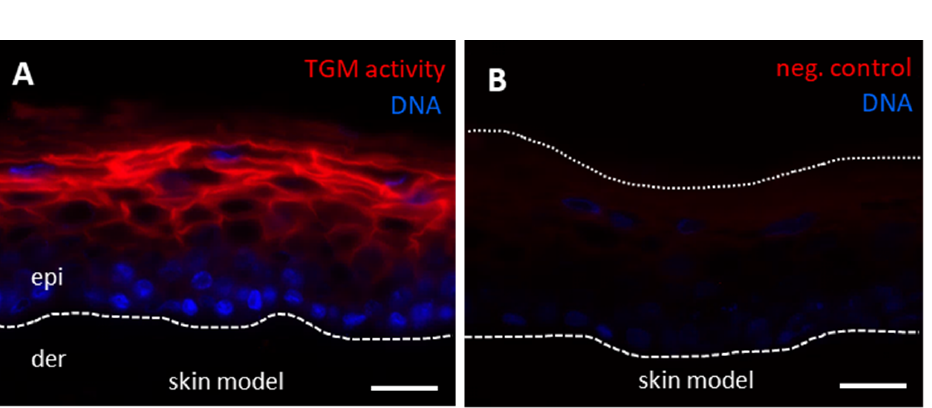
Figure 4. In situ labeling of transglutaminase (TGM) activity in chicken skin models and chicken skin. Skin models consisting of keratinocytes and fibroblasts isolated from chicks and cultured in vitro ( A , B ) and back skin ( C , D ), reticulate scales ( E , F ) and scutate scales ( G , H ) from chicken em- bryos (Hamburger and Hamilton stage 44) were cryosectioned and incubated with Alexa-fluor 555- cadaverine (red) in buffer containing either calcium ( A , C , E , G ) or, as negative (neg.) control, EDTA ( B , D , F , H ). Nuclear DNA was labeled with Hoechst 33258 (blue). The images were recorded with an Olympus BX63 microscope ( A , B , E – H ) and a Zeiss 980 confocal laser scanning microscope ( C , D ). The brightness of the images in panels ( A – D ) was uniformly increased by 20%. White dashed lines indicate lower border of the epidermis ( A – H ) and white dotted lines indicate the upper border of the epidermis in images of negative control samples ( B , D , F , H ). Scale bars = 20 µm ( A – F ), 50 µm ( G , H ). der, dermis; epi, epidermis; per, periderm. TGM activity was also detected in a membrane-associated pattern in the suprabasal layers of the chicken esophageal epithelium, whereas no activity was present in the three